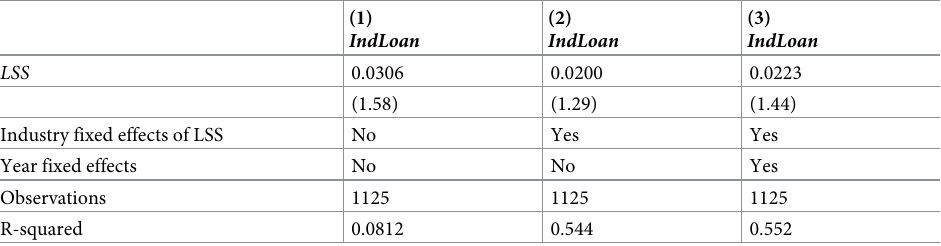
Table 9. The largest state-owned shareholder and bank loans. This table reports the estimation results from OLS regressions analyzing the impact of the largest state-owned shareholder on bank lending to their industry, with a differ- ent combination of fixed effects in each column. Columns 1–3 uses IndLoanS as the dependent variable. Variables are defined in S1 Appendix. The sample period is from 2007 to 2020. In parentheses are t-statistics. ��� , �� , � indicate statis- tical significance at the 1%, 5%, and 10% level,